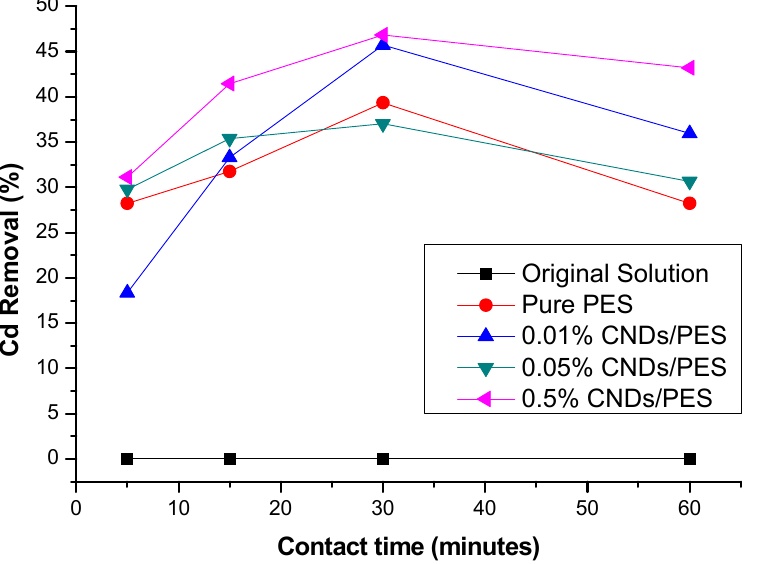
Figure 10. Effect of pH for the removal of cadmium(II) from standard solutions. The effect of the contact time in removing Cd 2+ from 10 ppm standard solution was optimised by applying Pure PES, 0.01% CNDs/PES, 0.05% CNDs/PES and 0.5% CNDs/PES membranes for 60 min. The current signals for all membranes decreased for the first 30 min, which meant that adsorption of Cd 2+ took place within that period (Figure 11). Thereafter, there was a sharp increase from 30 min to 60 min. This trend was as a result of the CND concentration gradient: as the contact time between the composite membrane and Cd(II) solution increased, more Cd(II) ions were able to reach additional adsorption active sites until equilibrium was reached. The 0.5% CNDs/PES membrane composite demonstrated the highest adsorption efficiency compared to pure PES, 0.01% CNDs/PES and 0.05% CNDs/PES composite membranes. This was due to the increase of the CNDs embedded to the PES membrane, which increased the active sites of the composite membrane; 0.5 % CNDs/PES membrane removed most Cd(II) (46.81%) at pH 5 within 30 min of treatment. There was no further increment in percentage removal with the increasing time and this could be due to the saturation of the Cd(II) ions in the membrane. The optimum time was therefore 30 min for this study.